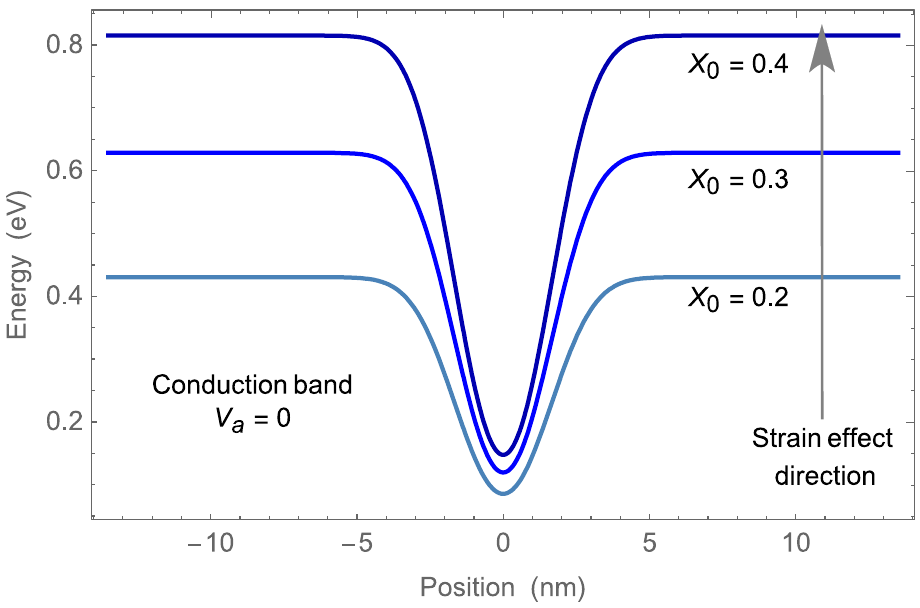
Figure 3. Strain effect direction for conduction band of the In x Ga 1-x N/GaN parabolic LED structures with various mole fractions ( x 0 ) at an applied bias of 0 V.